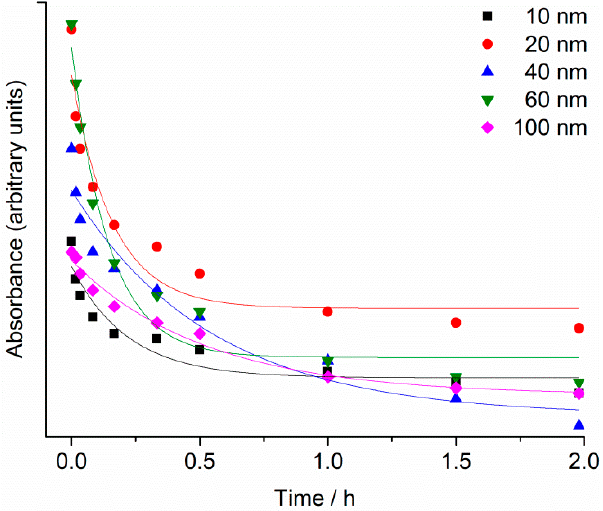
Figure 1. Temporal change in SPR maximum absorbance for 10, 20, 40, 60 and 100 nm AgNPs (1 mg L − 1 ) in FSW.